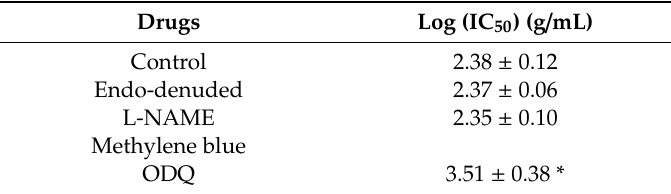
Table 1. E ff ect of N. ramosissima (Nr) on the vascular response to di ff erent vasoactive substances on the nitric oxide pathway in rat aorta.